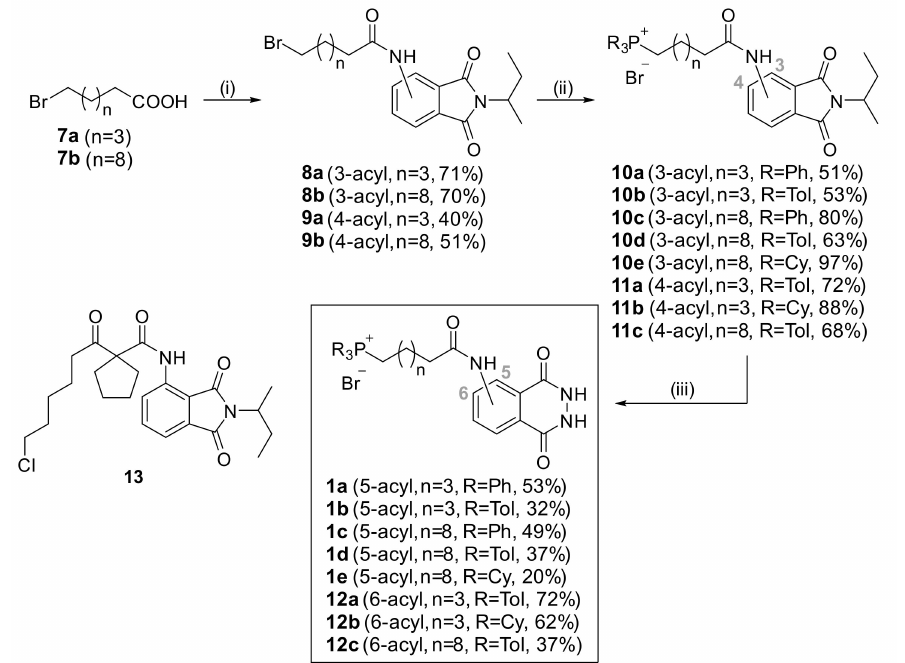
Scheme 3. Synthesis of phosphonium bearing phthalhydrazides.